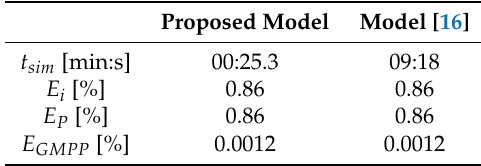
Table 4. Simulation time and mean absolute percentage errors for the SP simulation test.